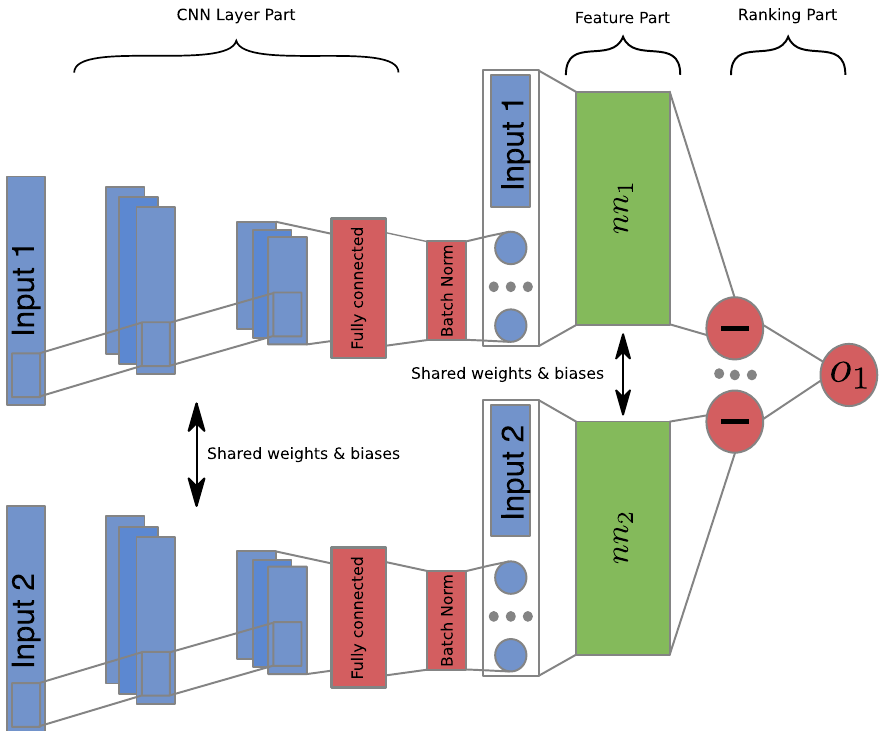
Figure 3. Adaptation of the DirectRanker architecture to use convolutional layers to extract additional features from the inputs. The two convolutional networks share their parameters and architecture. After the convolutional layers, a fully connected layer is used the further reduce the extracted features before they are concatenated with the original ones. The concatenated features are then fed into the original DirectRanker model 12 . During training, a batch normalization layer 37 is used before the extracted features are added to the primary ones to prevent overfitting.